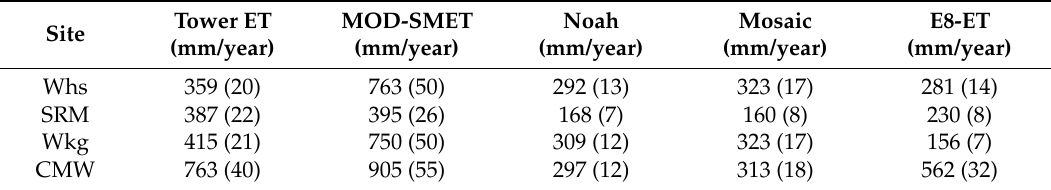
Figure 8. Comparison between daily average ET estimates derived by NLDAS-2 Noah and Mosaic models, as well as MOD-ET to observed daily average ET at sites: Whs ( A ); SRM ( B ); Wkg ( C ); and CMW ( D ). Table 4. Comparison of eddy covariance Tower ET with MOD-SMET, Noah, Mosaic, and E8-ET calculated ET. Values are annual total ET estimates for year 2013 and standard errors are in